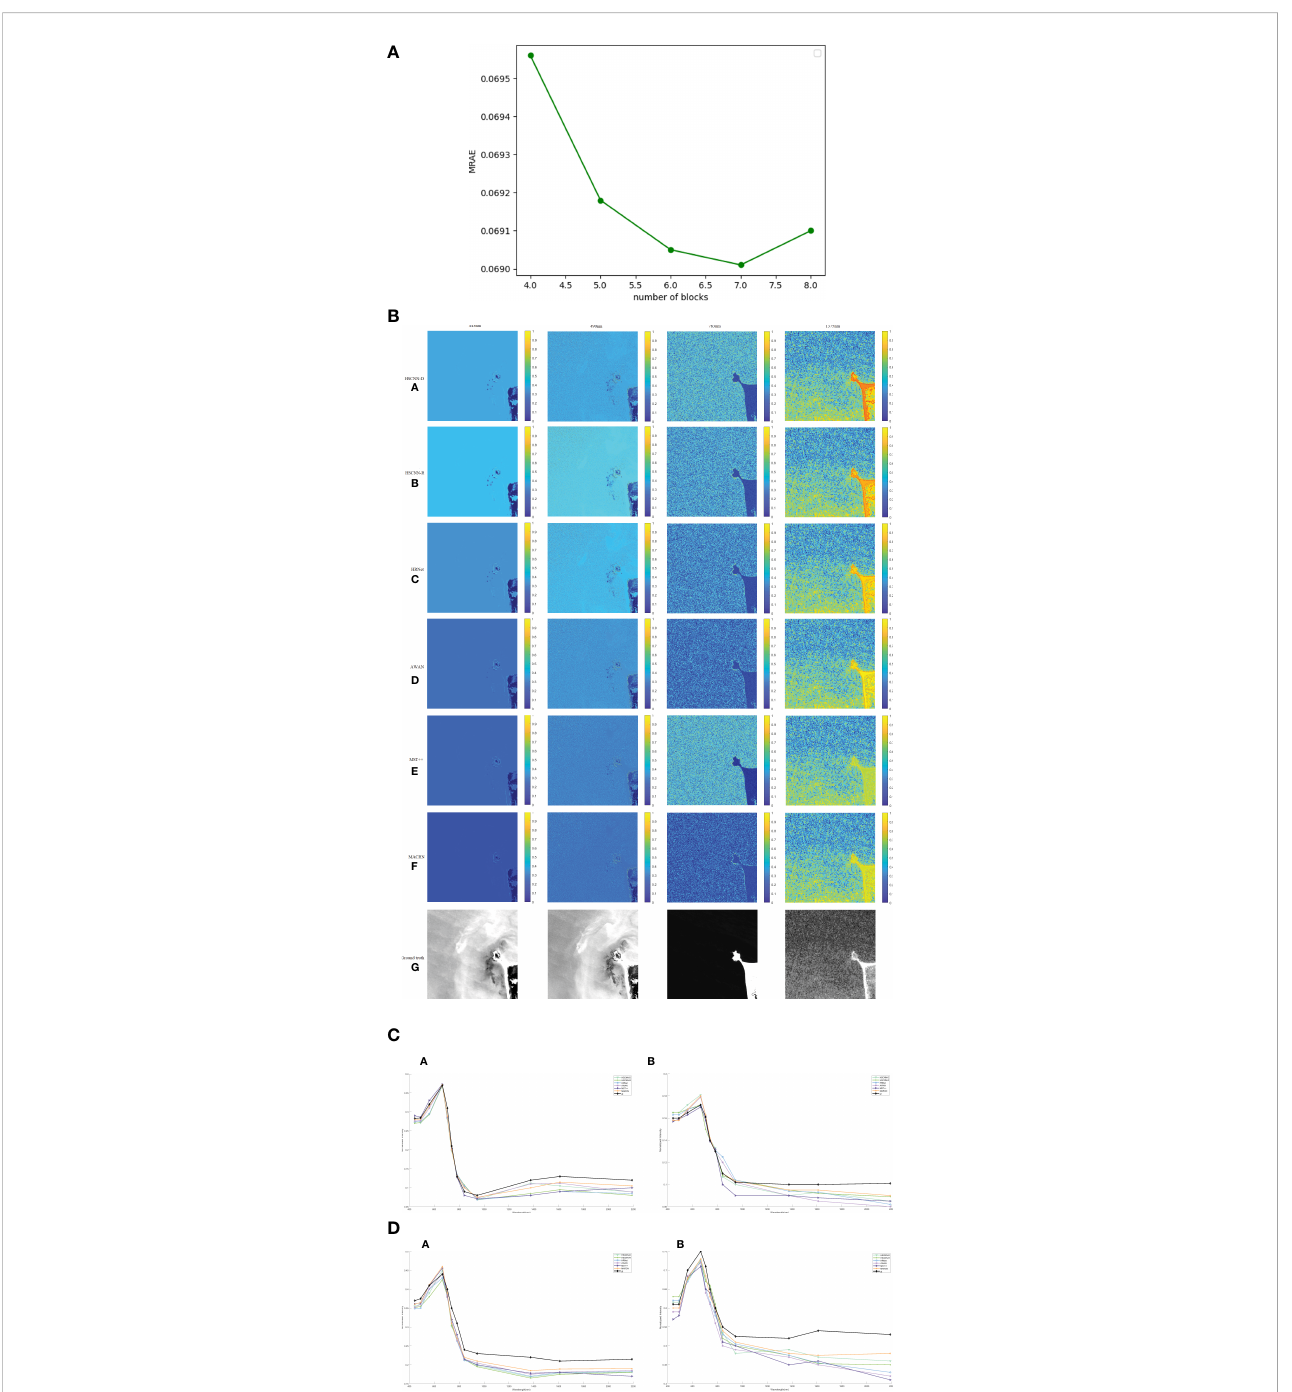
Realworld data of fi ve models.